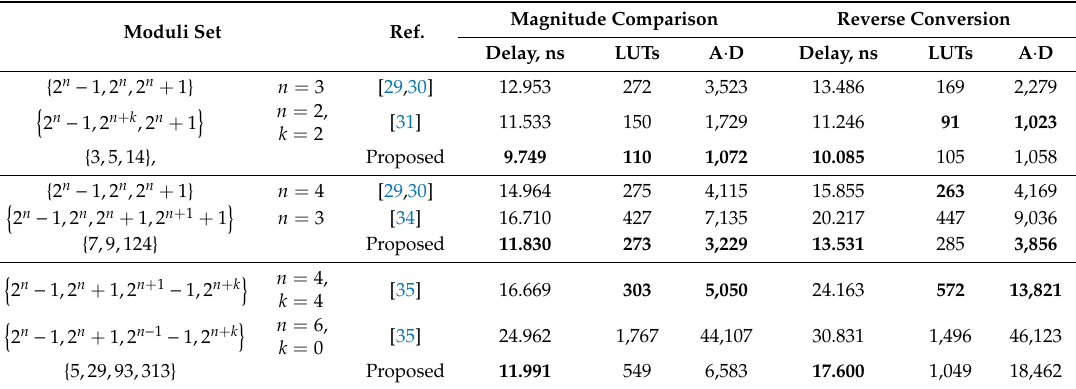
Table 4. Modeling results of magnitude comparison and reverse RNS to binary conversion for proposed and balanced moduli sets. Magnitude Comparison Reverse Conversion Moduli Set Ref. Delay, ns LUTs A · D Delay, ns